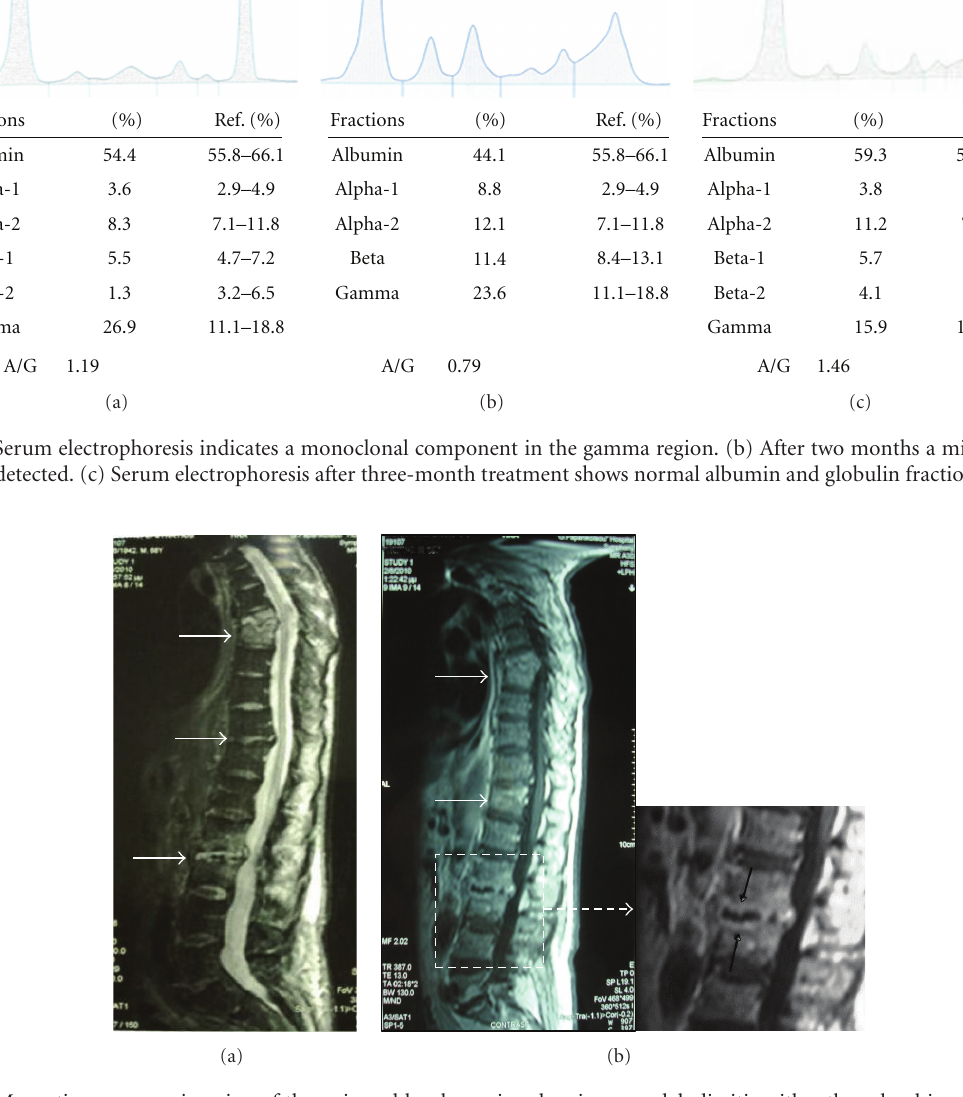
Figure 3: (a) Magnetic resonance imaging of thoracic and lumbar spine showing spondylodiscitis with a three-level involvement; T7-T8, T11-T12, and L2-L3 (white arrows). (b) A typical lesion is shown in the enlarged frame of the L2-L3 level; ellipsoidal contrast enhancement of the vertebral end-plates and the anterior aspect of the related disc space (black